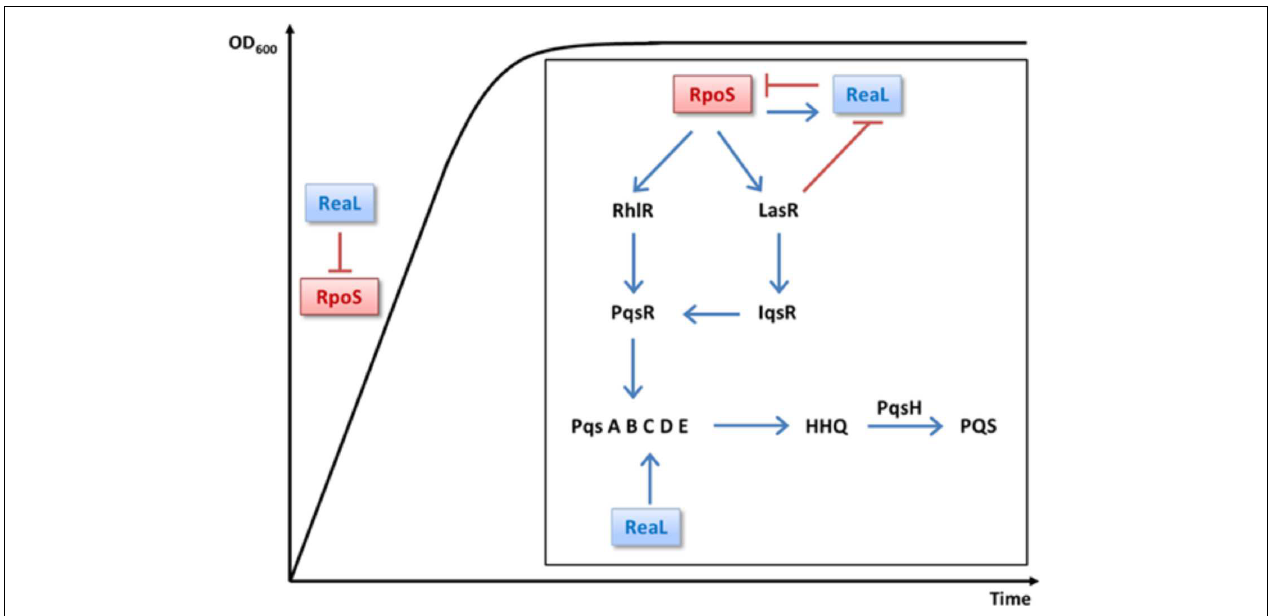
FIGURE 4 | Integration of ReaL in the multi-layered quorum sensing cascade. σ 70 -dependent reaL transcription occurs during logarithmic growth (Sorger-Domenigg, 2010; Carloni et al., 2017). Continuous ReaL synthesis may prevent rpoS translation during logarithmic growth to avoid needless gene expression. When the cells encounter stationary phase, RpoS-mediated transcription of reaL increases through RpoS (Carloni et al., 2017), which in turn leads to repression of rpoS translation by a mixed negative feedback loop. When the cell density increases, LasR bound to its cognate autoinducer represses reaL transcription (Carloni et al., 2017), alleviating ReaL-mediated repression of RpoS synthesis, which in turn would stimulate LasR and RhlR synthesis (Schuster et al., 2004), and consequently the synthesis of PqsR and IqsR. Thus, in conjunction with other upstream regulators (Lee and Zhang, 2015), RpoS would act on top of a coherent feed-forward loop that serves to induce QS dependent genes. Positive and negative regulation is denoted by arrows and bars, respectively.